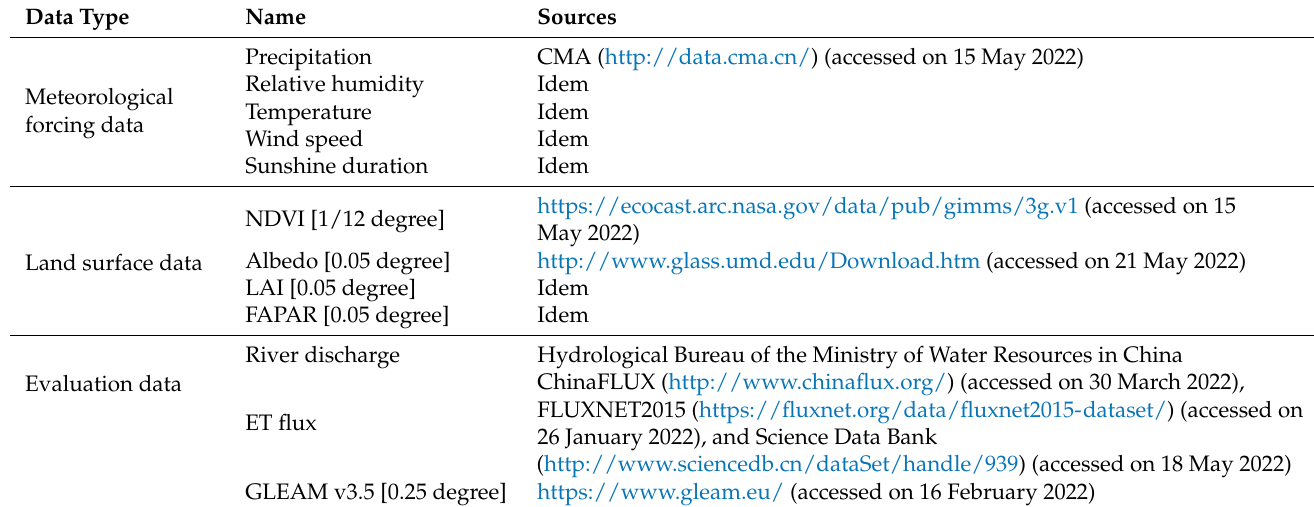
Table 2. Details of model forcing data and evaluation